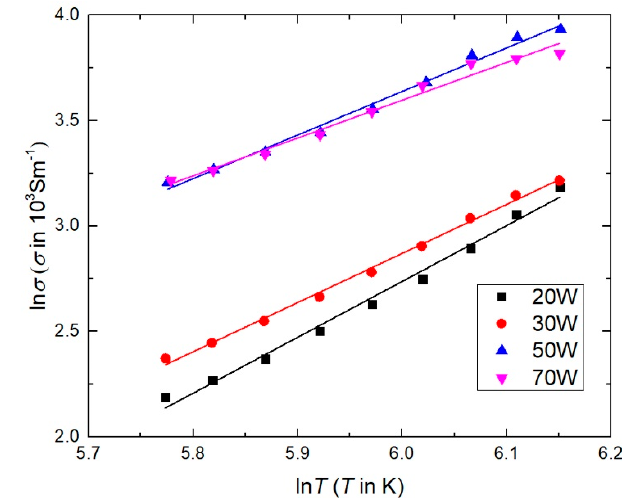
Figure 7. Curve fittings of the conductivity of the Bi 2 Te 3 films